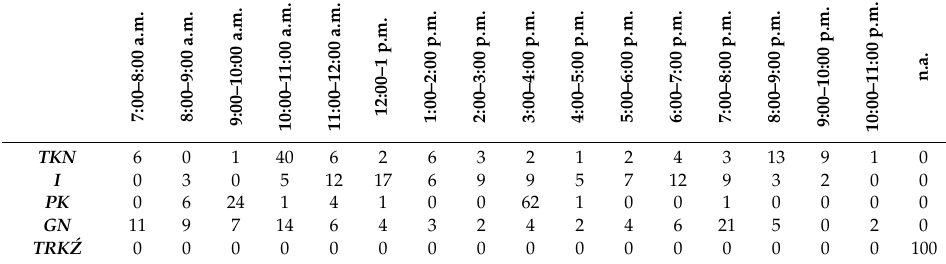
Table 14. Reactions of Internet users on particular times of posting on FB